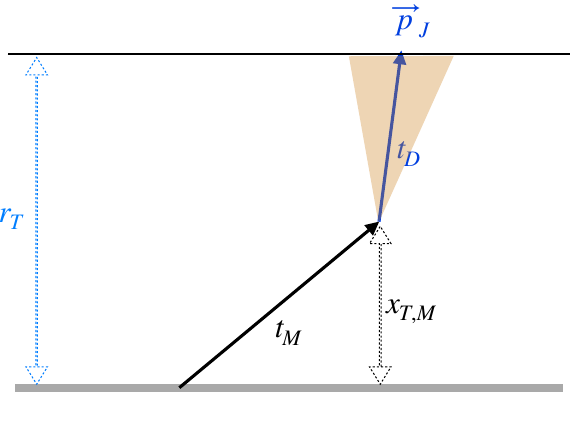
= 0 . 75 m and η = 2 (red solid T,M M